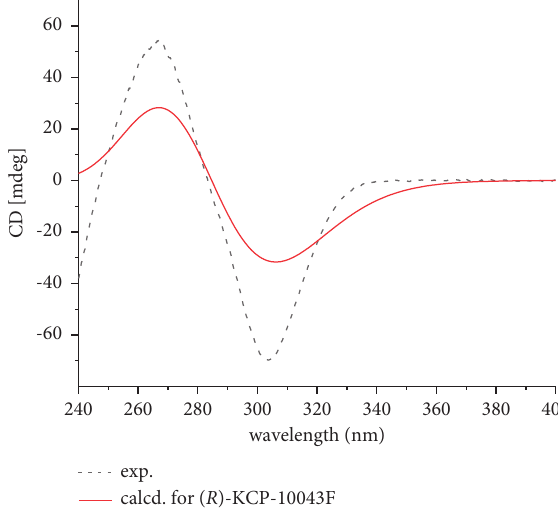
Figure 5: Experimental and TDDFT-calculated ECD spectrum of R -( − )- KCP-10043F . Table 1: Non-mutagenic effects of racemic (±)-KCP10043F and its two enantiomers in Salmonella typhimurium (TA) and Escherichia coli (E. coli) strains with S9 and without S9 a .